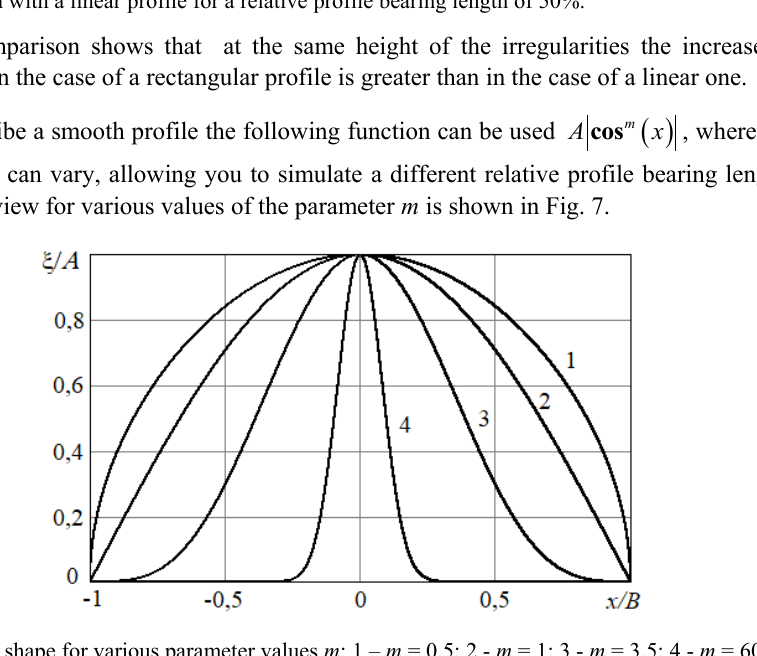
Fig.6. The dependence on the frequency of losses per unit length in a rectangular waveguide is 1.1 x 0.55 mm with a linear profile for a relative profile bearing length of 50%.